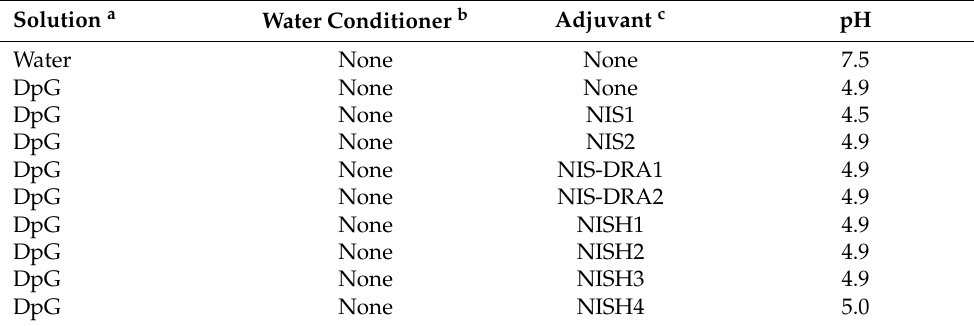
Table 7. pH for dicamba plus glyphosate solutions at 559 and 1541 g ae ha − 1 , respectively, with and without non-AMS water conditioner alone and tank mixed with 10